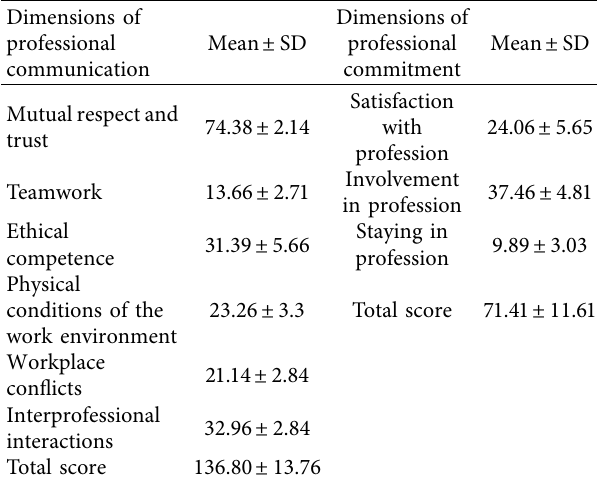
Table 2: The means and standard deviations of the participants’ professional communication and professional commitment